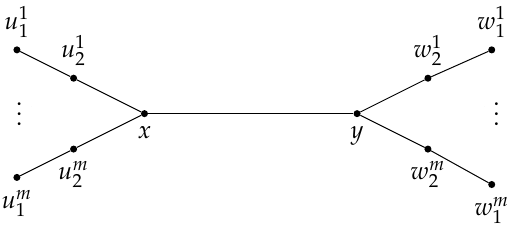
Figure 1. A healthy spider S m .